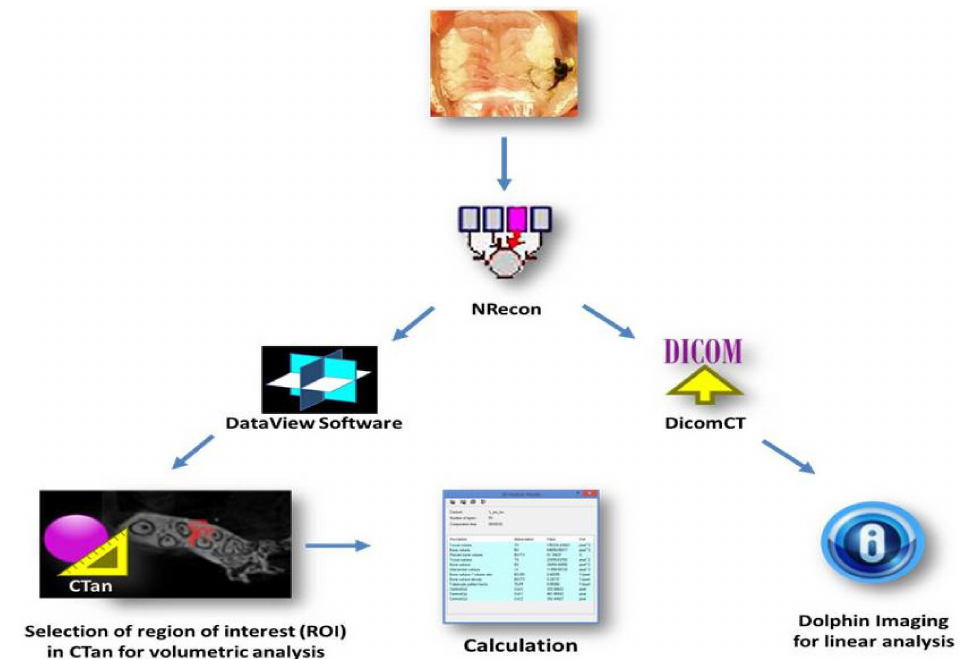
Figure 6. Scanner sequence of maxilla and linear and volumetric analysis by the software